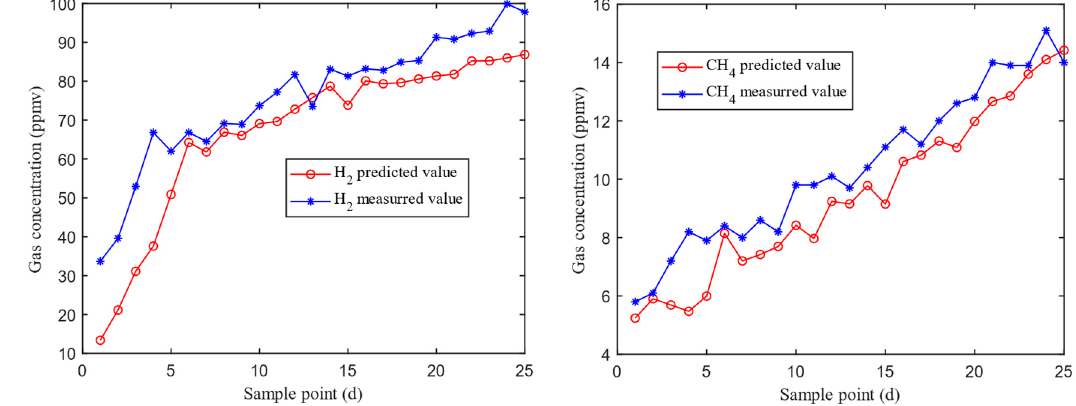
Figure 4. The predicted vs. measured DGA data of H 2 and CH 4.